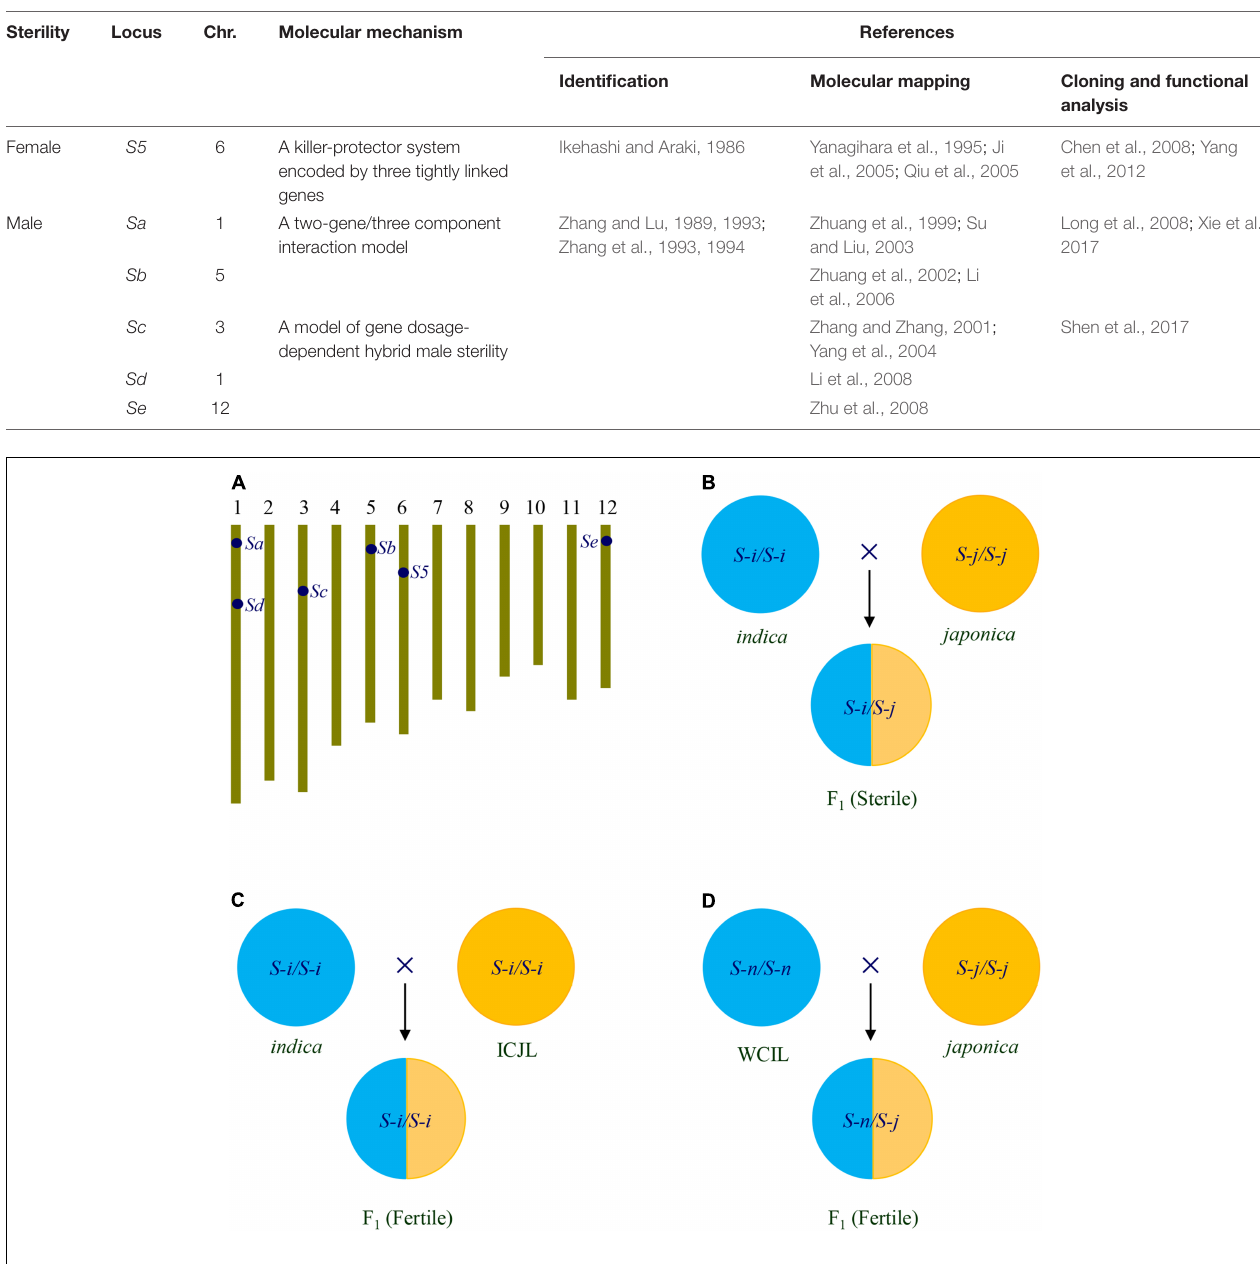
TABLE 1 | The loci for indica - japonica hybrid sterility. Sterility Locus Chr. Molecular mechanism